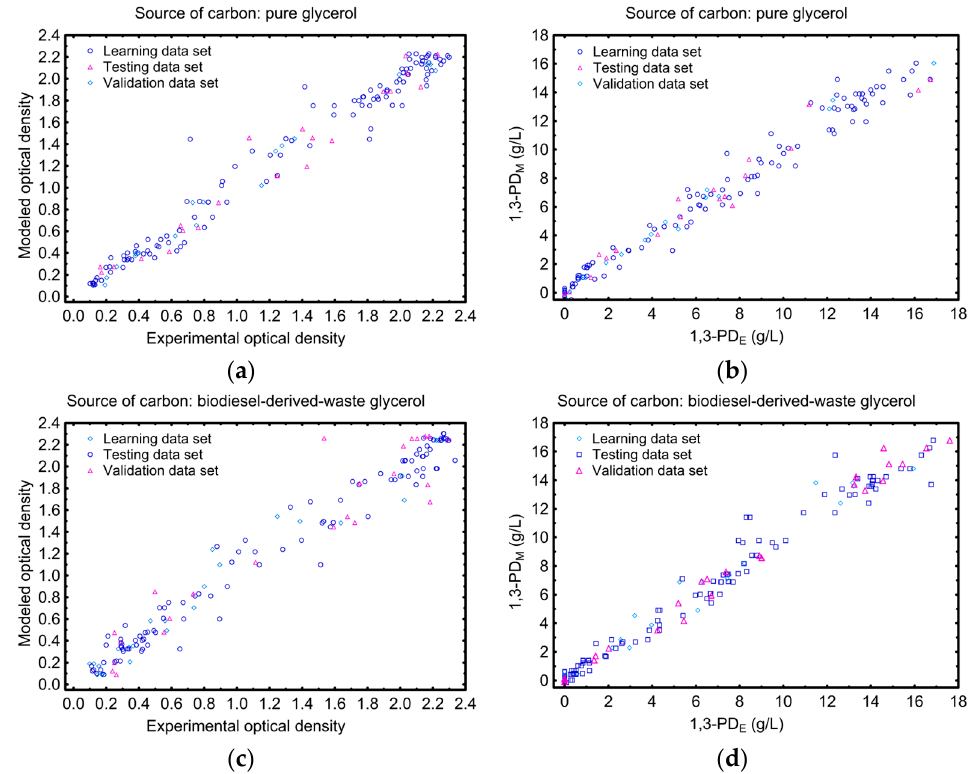
Figure 10. A comparison of the artificial neural network model (ANN-M Cf_PD ) predictions against the experimental data describing the growth of C. freundii population and the production of 1,3- propanediol on pure ( a , b ) and biodiesel-derived waste glycerol ( c , d ), respectively. Table 9. Values of indicators used to evaluate performance of the ANN-M Cf_PD model to predict the growth of C. freundii population and the production of 1,3-propanediol on used glycerol-based media computerized for all data sets: L—learning, T—test, V—validation,